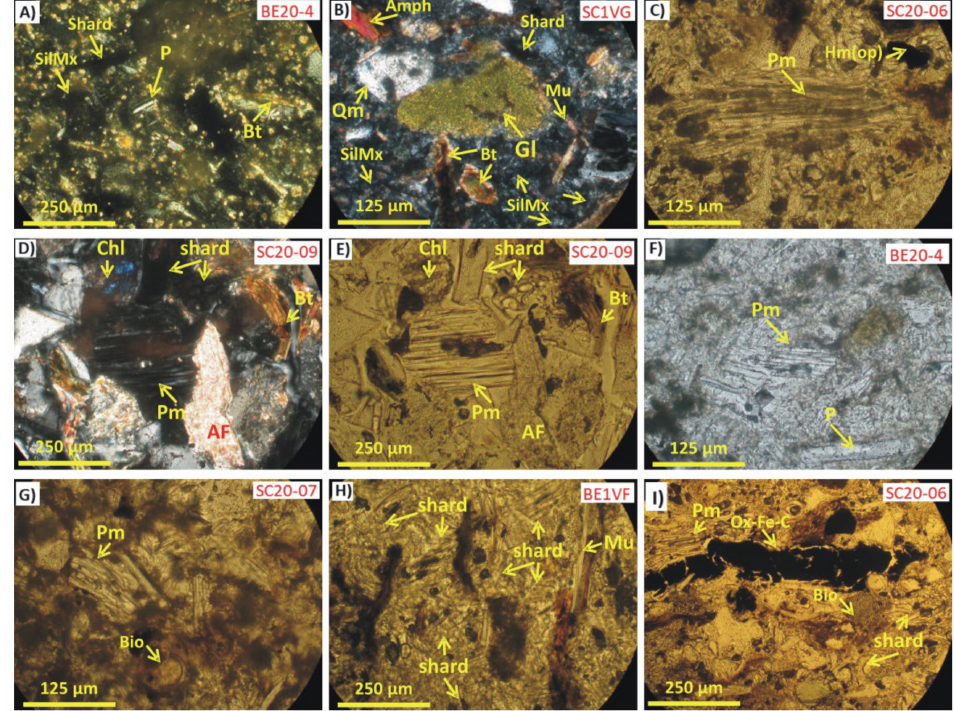
Figure 6. Photomicrographs from petrographic thin sections illustrating diagnostic grains of Santa Caterina (SC) and Belmonte (BE) outcrops. ( A ) Volcaniclastic bed showing silt-sized plagioclase (P) and dominant shards. SilMx: siliciclastic matrix (mainly includes silt to clay-sized shards and pumice). Bt: biotite flake. ( B ) Glauconite (Gl) in a volcaniclastic interval. Amph: amphibole. Bt: biotite. Mu: muscovite. SilMx siliciclastic matrix (mainly shards, pumice and phyllosilicates). Qm: monocrystalline quartz. ( C – I ) Volcanic grains (Lv) such as pumice (Pm) and shards with different and diagnostic shapes. P: plagioclase lath. AF: undetermined altered feldspar. Bt: Biotite. Mu: muscovite. Chl: chlorite. Hm(op): opaque heavy minerals. OX-Fe-C: Oxid-Fe cement. Bio: bioclast (single skeleton). ( A , B , D ) are crossed-nicols photomicrographs; ( C , E – I ) are plane-polarized-light